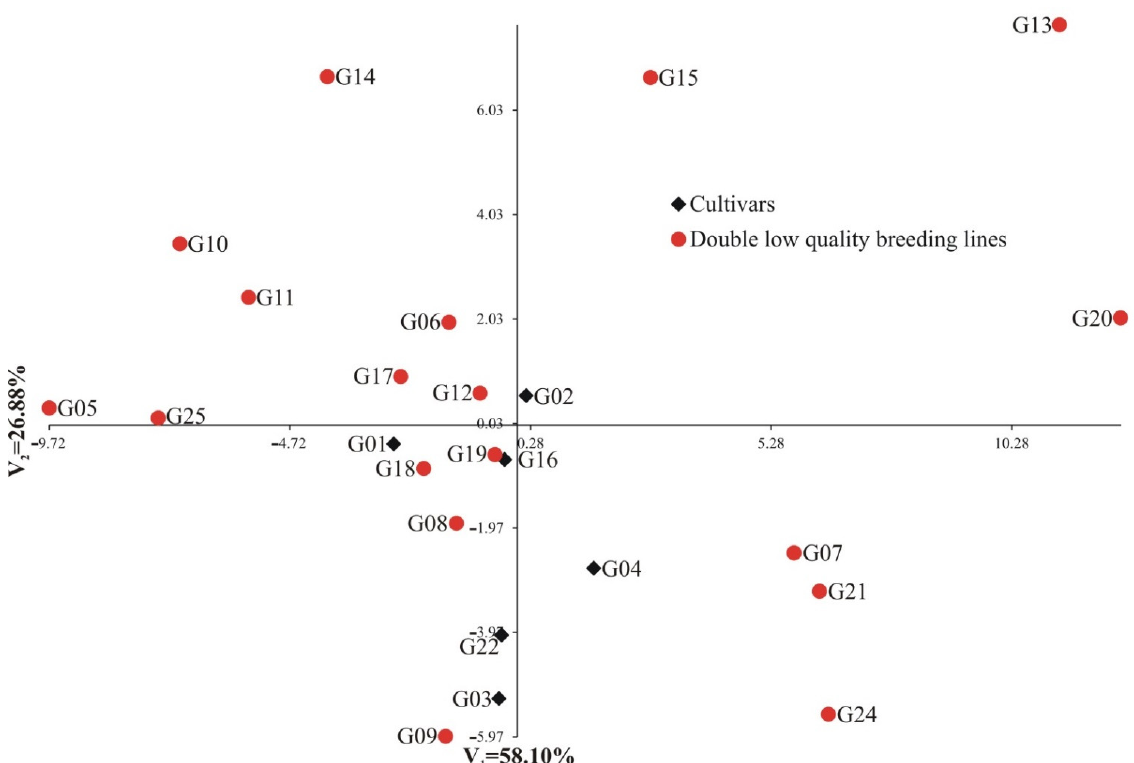
Figure 6. Distribution of 25 genotypes of winter oilseed rape ( Brassica napus L.) in the space of the first two canonical variates in Ł agiewniki 2015.